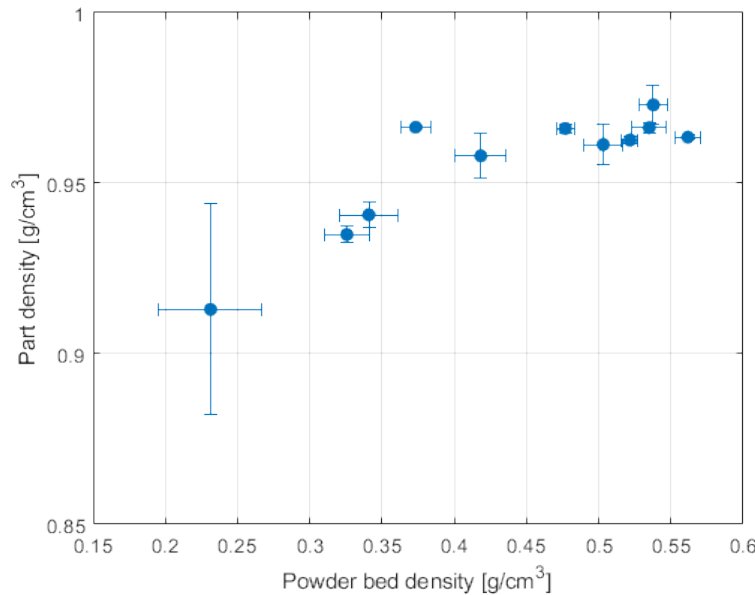
Figure 1. Powder bed density vs. part density for a single powder, data from Vetterli [16].